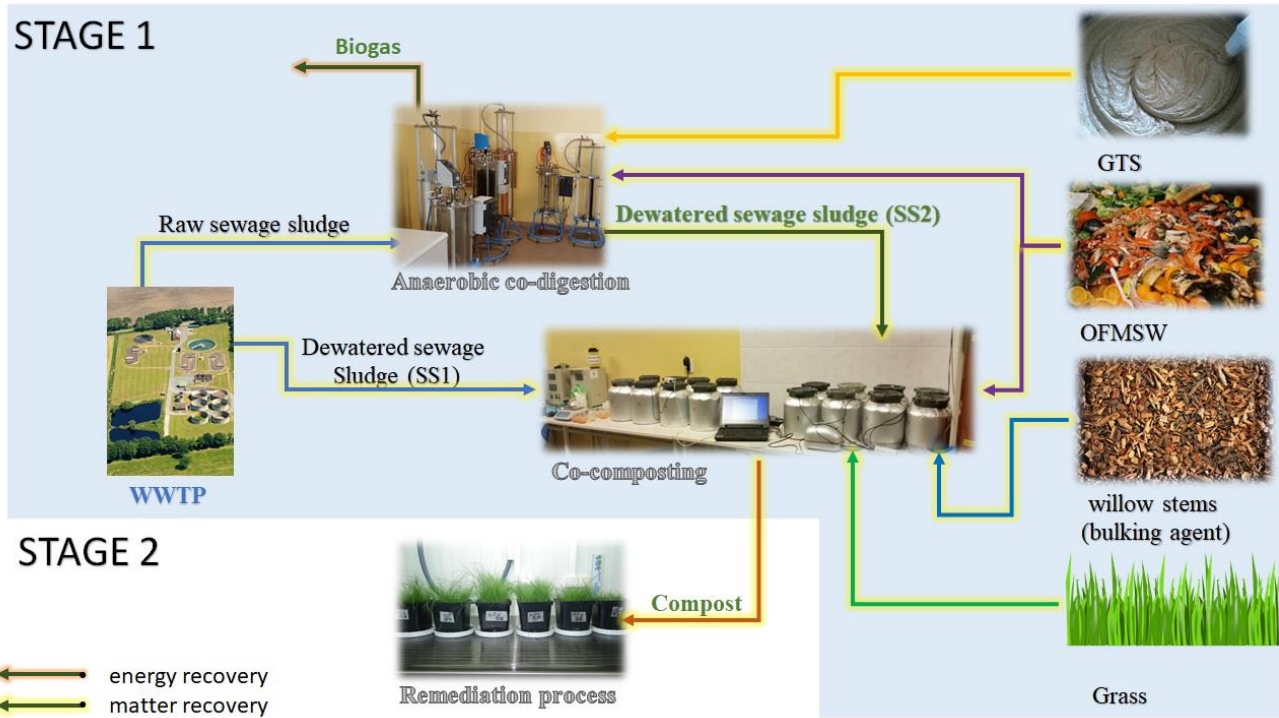
Figure 2. Experiment scheme (blue background: stage 1, composting process; white background: stage 2, remediation process).